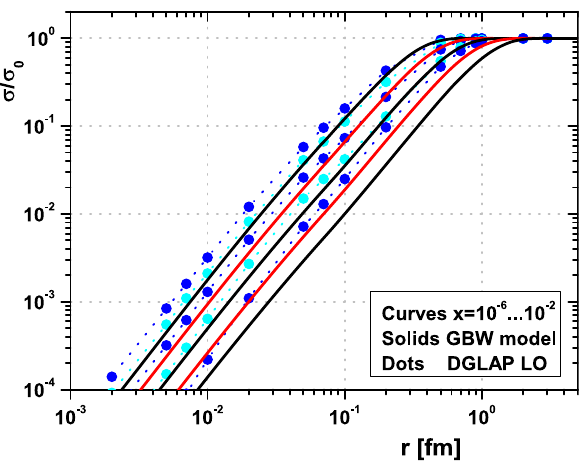
Fig. 1 The extracted ratio σ dip /σ 0 as a function r for x = 10 − 6 ... 10 − 2 (curves from left to right, respectively) from the parameterization of F 2 within the LO approximation (circle-dot curves), Eq. (22), compared with the GBW model (solid curves), Eq. (3)